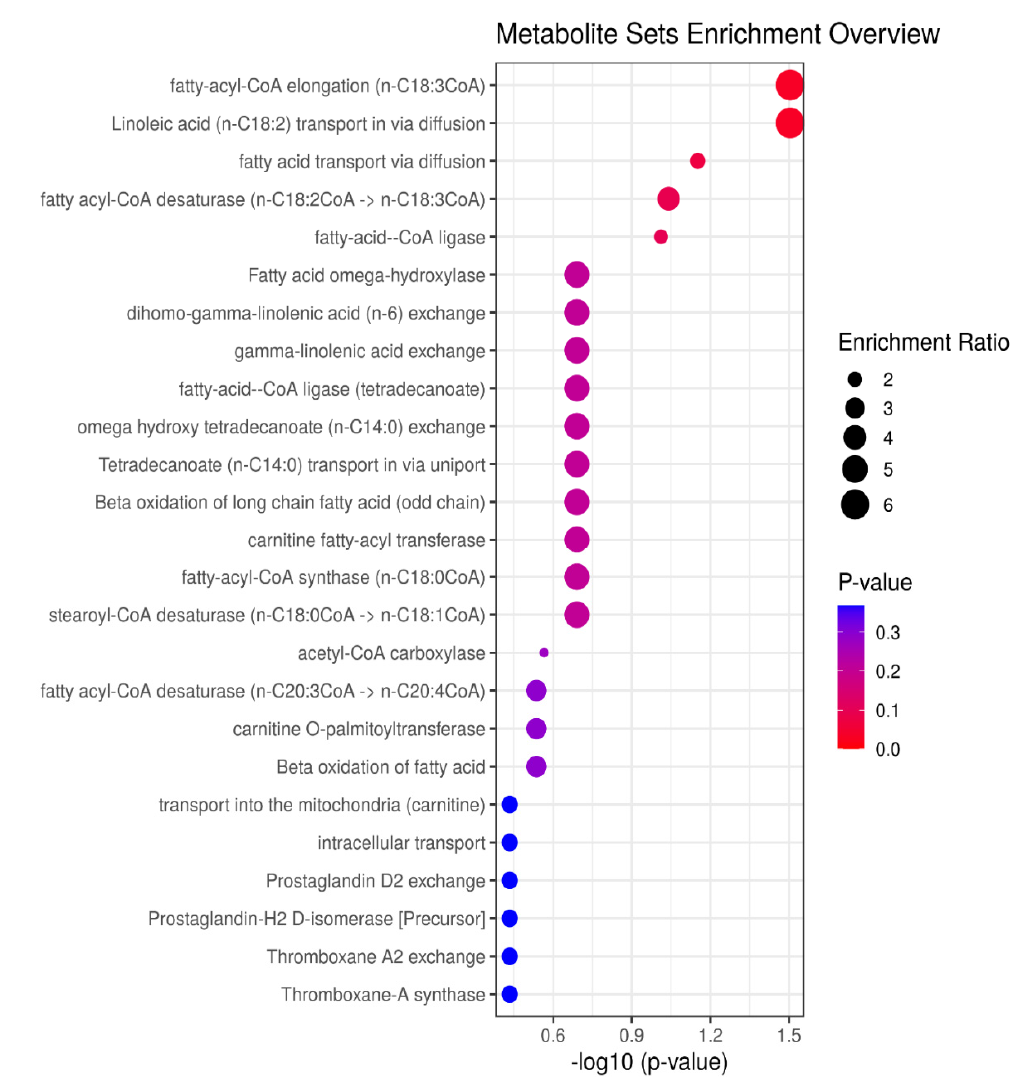
Figure 3. Results of the metabolite set enrichment analysis. Fatty acyl coA elongation, p = 0.03; linoleic acid (n-C18:2) transport in via diffusion, p = 0.03; fatty acid transport via diffusion, p = 0.07; fatty acyl-CoA desaturase, p = 0.09; fatty-acid-CoA ligase, p = 0.09.